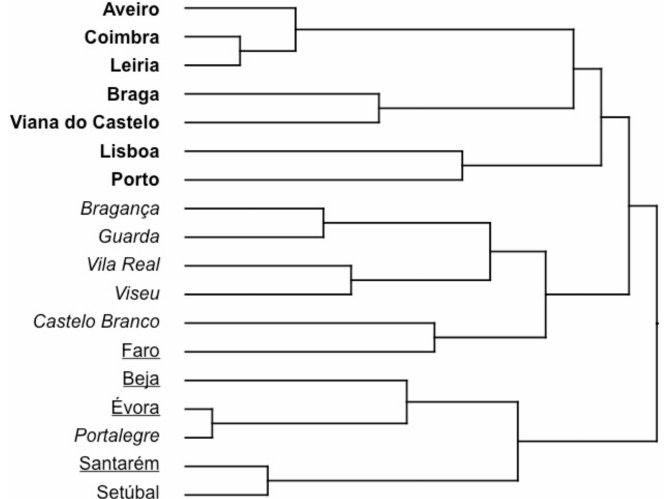
Figure 4. Regional clustering dendrogram as a function of FWI thresholds ( ≥ 1 ha, and ≥ 100 ha), population density, and biophysical variables (TRI, elevation, NPP, land cover fractions of agriculture, shrubland, forest, and flammable forest). Bold, italic, and underlined lettering indicates regions belonging respectively to the NCW, NCE, and S supra regions of